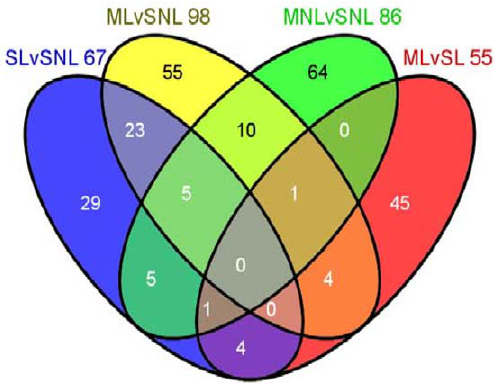
Figure 2. Differential profiles of transcript levels in saline- and METH-treated 6-OHDA-induced hemiparkinsonian rats. The Venn diagram shows the distinctiveness and the overlap of genes identified by the four separate comparisons shown in the figure. The rats were treated and euthanized as described in the text. RNA was extracted from striatal tissues obtained from both sides of the brains of saline- and METH-injected hemiparkinsonian rats. Microarray analyses were performed as described in the text. Genes were identified as differently expressed if they showed greater than 6 1.7-fold changes at p , 0.025.